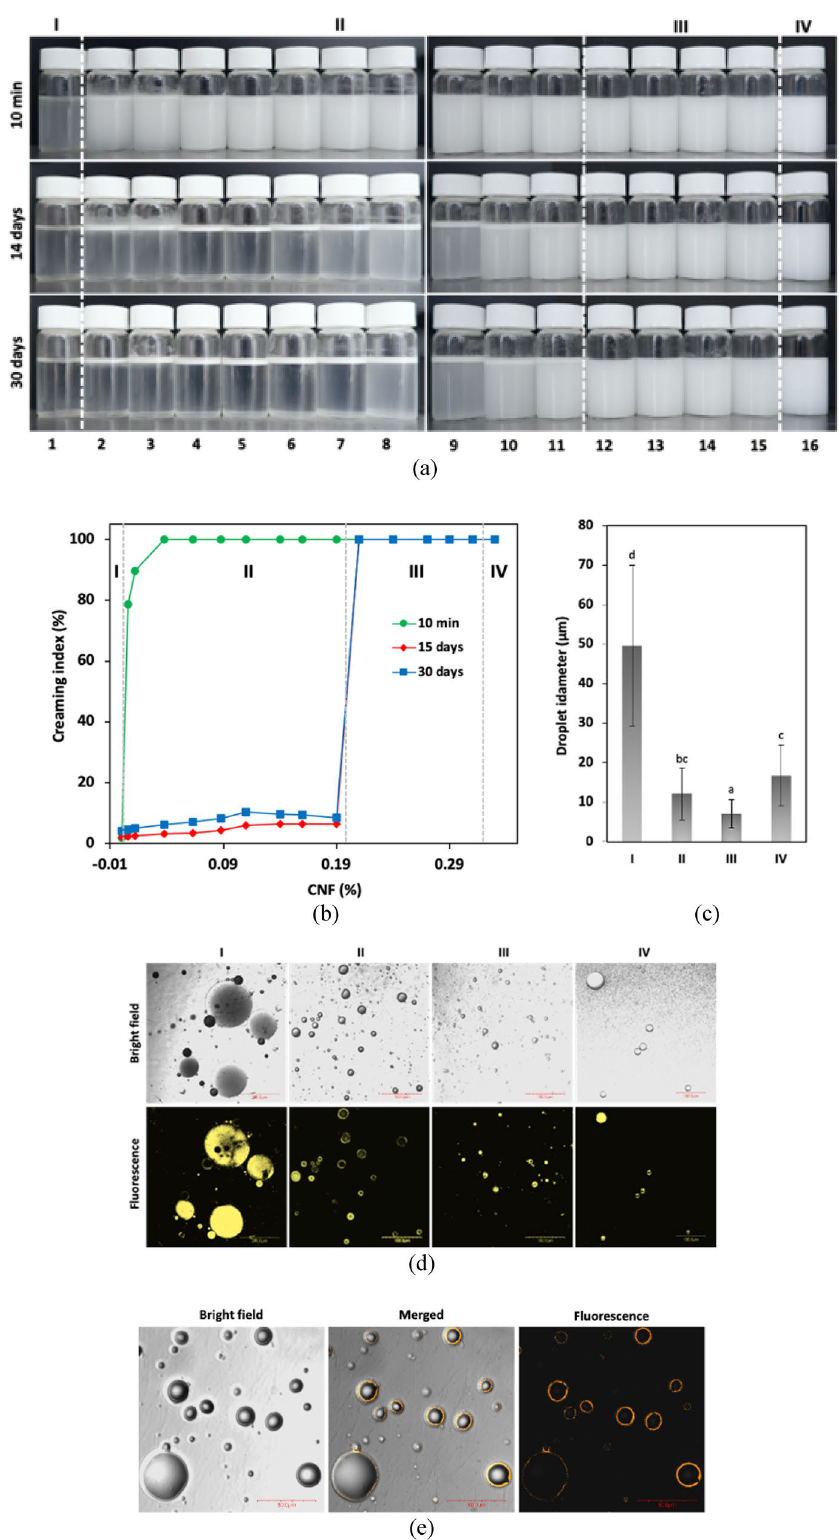
Figure 2. ( a ) Visual appearance of CNF-stabilized Pickering emulsions containing 0.5% SEO and CNF at various concentration of: 0, 0.006, 0.012, 0.038, 0.063, 0.088, 0.11, 0.14, 0.16, 0.19, 0.21, 0.24, 0.27, 0.29, 0.31% (from left to right, 1–15), and regular emulsion (16), and ( b ) their creaming index properties. ( c ) Droplet size distribution of emulsion, ( d ) confocal images of emulsion at day 7 after preparation, and ( e ) CNF-stabilized Pickering emulsion. The CNF was stained with acridine orange. Different letters indicate statistical significant differences at P <